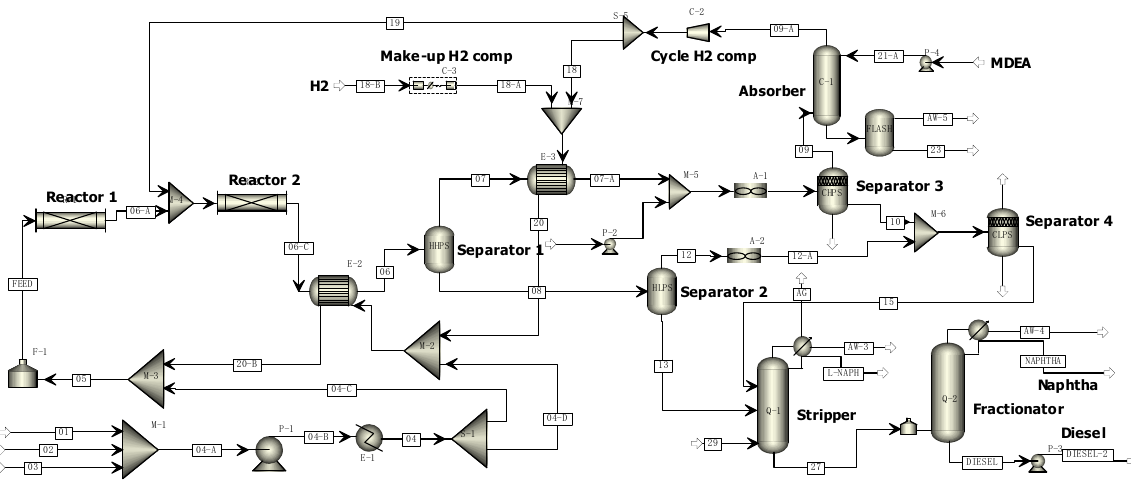
Figure 2. Aspen Simulation of a diesel HDT unit.